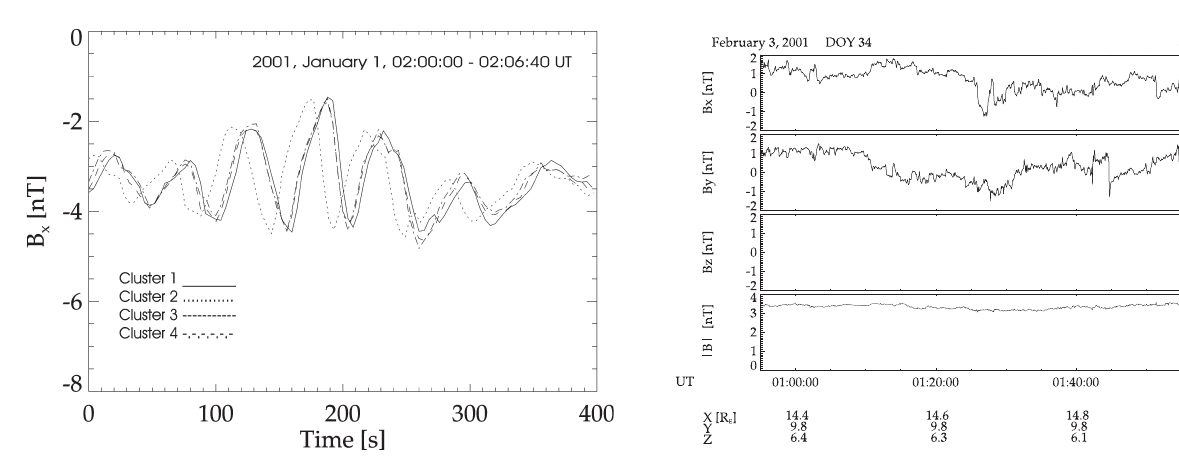
Fig. 8. Magnetic field measurements made on board the Cluster 1 spacecraft in the time interval 3 February 2001,